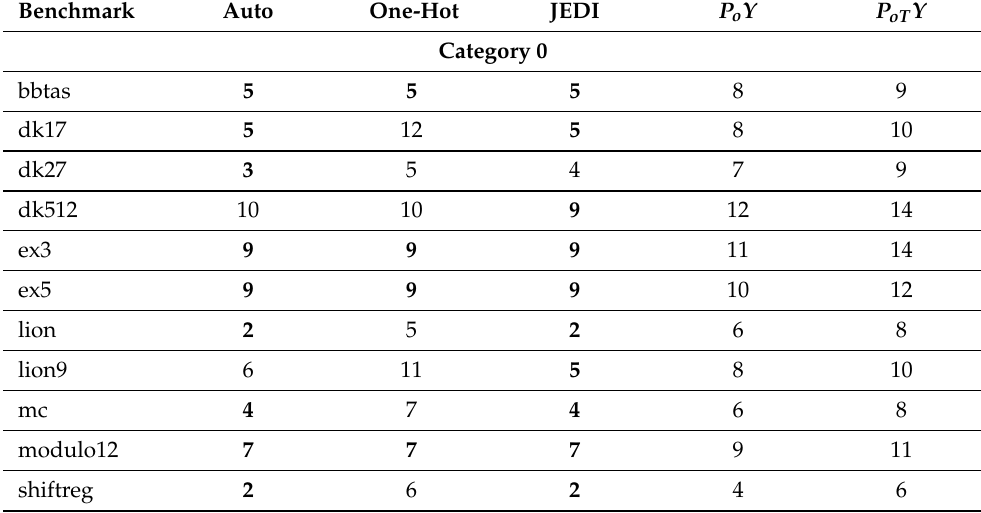
Table 16. Experimental results [132] (LUT